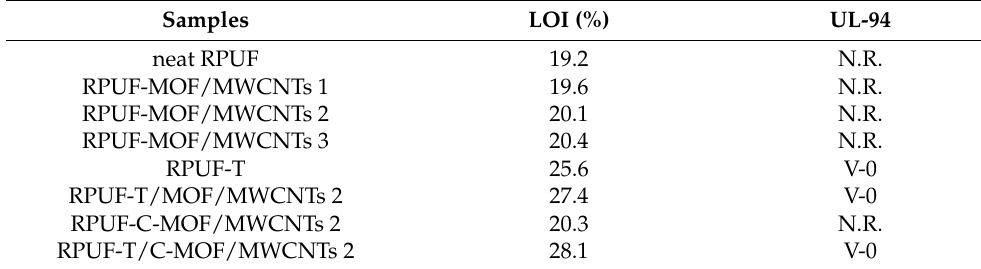
Table 3. LOI values and UL-94 ranks of RPUFs. Samples LOI (%) neat